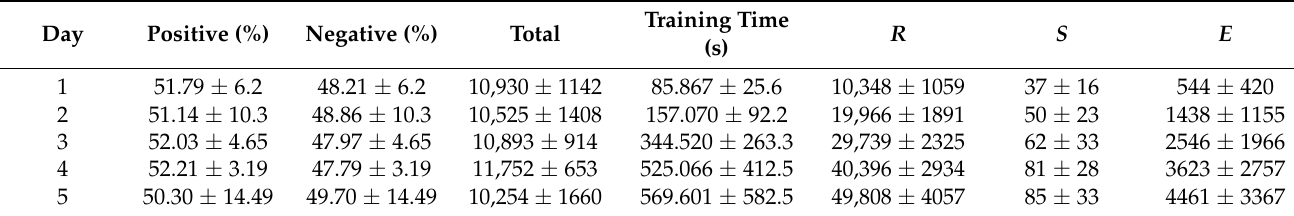
Table 4. Averaged characteristics of training data and training time of the incremental learning. R, S, and E indicate the number of reserve vectors, margin support vectors, and error support vectors,